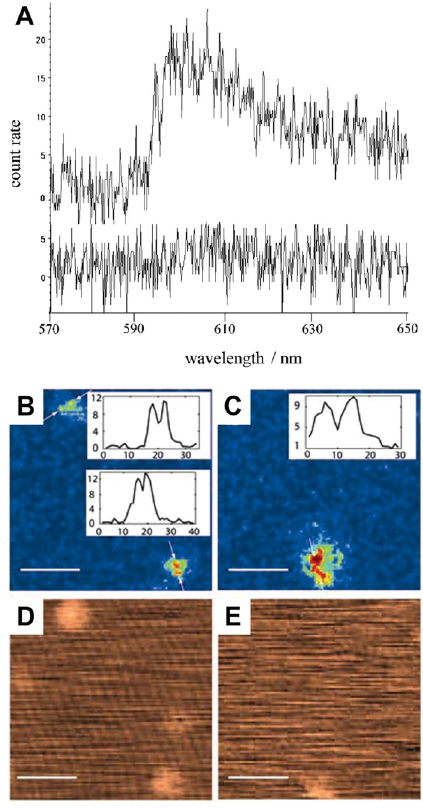
Figure 5: (A) Fluorescence spectra of Cy3 molecules when Si tip is approached (top) and retracted from sample (bottom). (B – C) Tip- induced fluorescence images of Cy3 molecules (pair) in different positions. (D – E) Corresponding AFM images of fluorescence images (B) and (C). The scale bars in (B – E) are 50 nm. Reprinted [106] with permission from Copyright 2006 by the American Physical